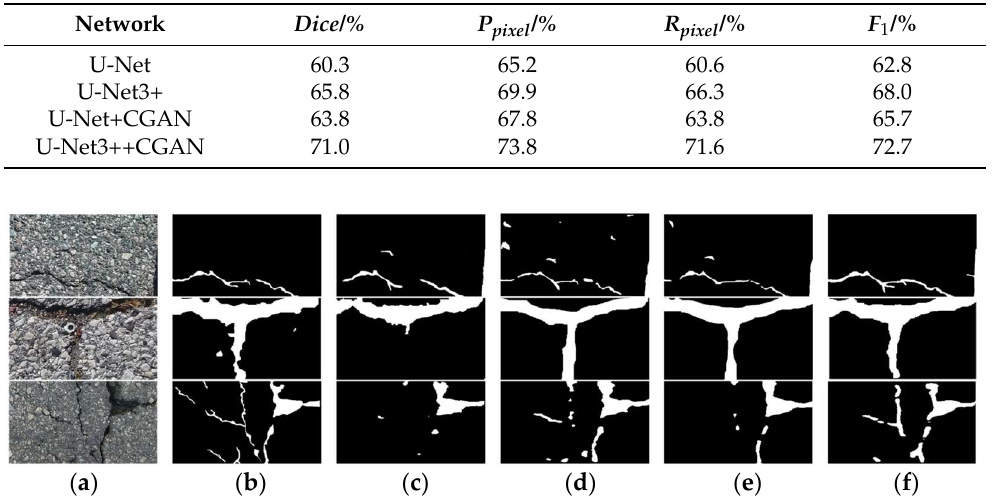
Figure 9. Visualization results of different networks. ( a ) Road Image; ( b ) Ground Truth; ( c ) U-Net; ( d ) U-Net3+; ( e ) U-Net+CGAN; ( f ) Ours.